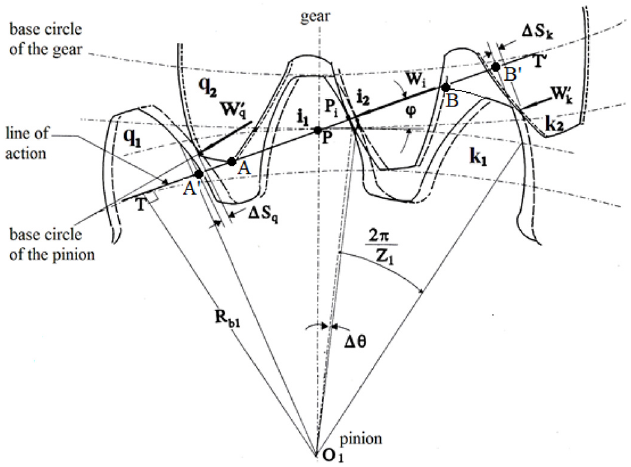
Fig. 1. Deformations of the pro fi les of the teeth under the effect of the k k , after the ideal engagement at point B . This situation 1 2 is represented by the dotted lines in Figure 1.